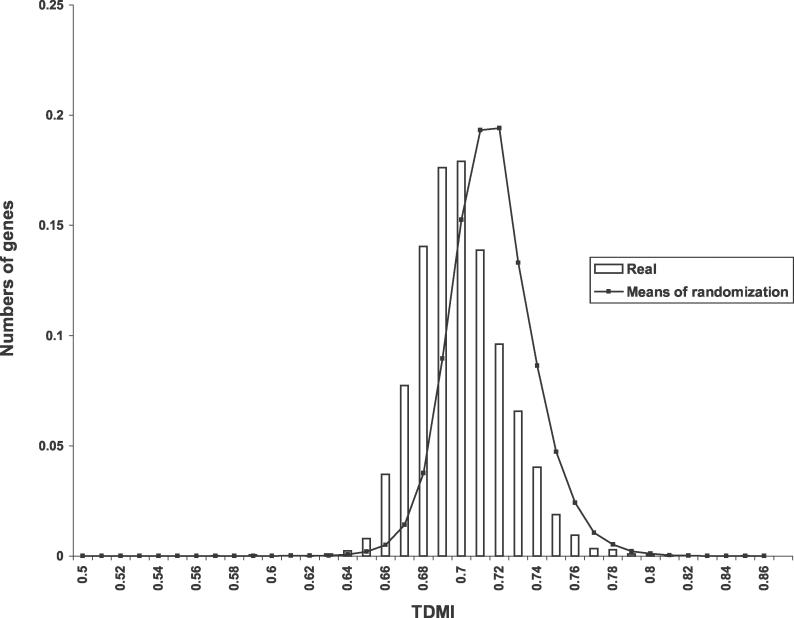
Distributions of Gene Average TDMI for E. coli MG1655 Genome and for Five Virtual GenomesThe open bars show the distribution for the MG1655 genome; the line shows the distribution for five virtual genomes composed of shuffled genes with identical length and GC% as the observed genes. The E. coli genome has a lower gene TDMI than expected from nucleotide composition (Student's two-tailed t-test p < 2.2 × 10−16).